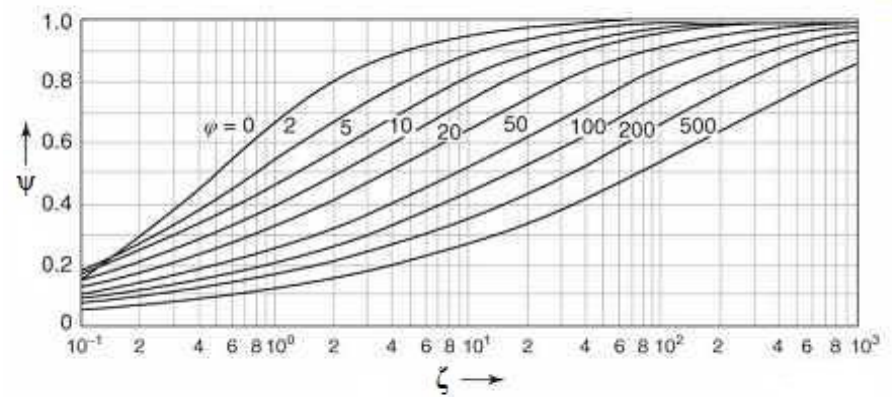
Figure 9. Graph of ψ coefficient as a function of cable stress intensity.